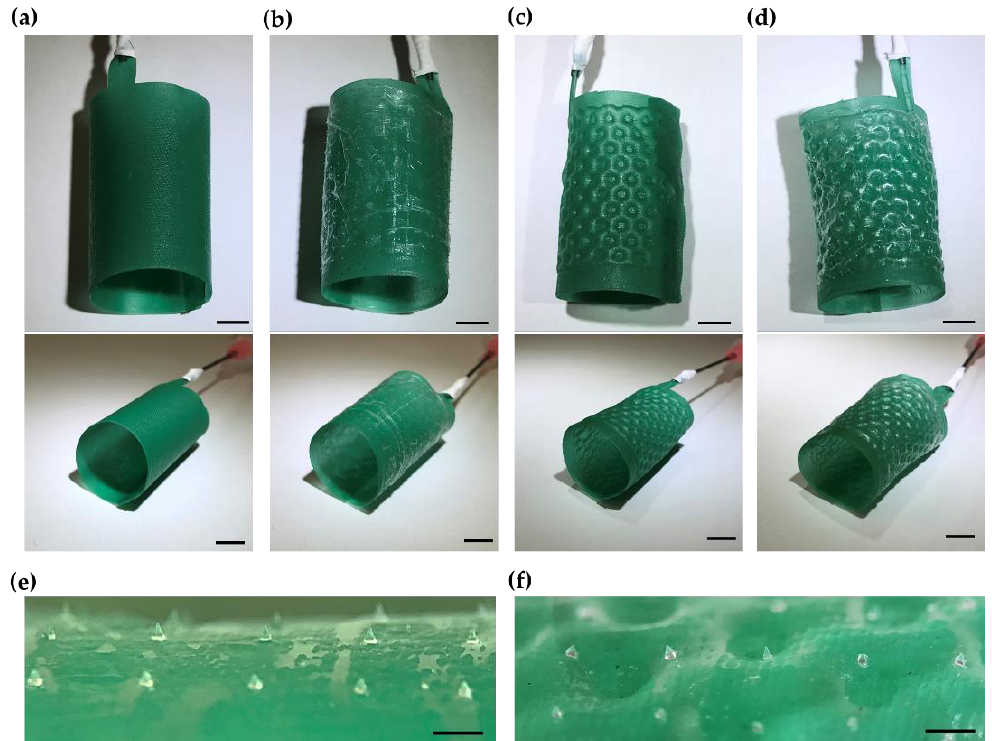
Figure 5. Microneedle-patterned soft robotic polyurethane stents. ( a ) Unpressurized stent without surface patterning; ( b ) Unpressurized stent with microneedle patterning; ( c ) Pressurized stent without surface patterning; ( d ) Pressurized stent with microneedle patterning; ( e ) Magnified view of the microneedles, unpressurized; ( f ) Magnified view of the microneedles, pressurized. Scale bar, 5 mm ( a – d ) and 1 mm ( e , f ).